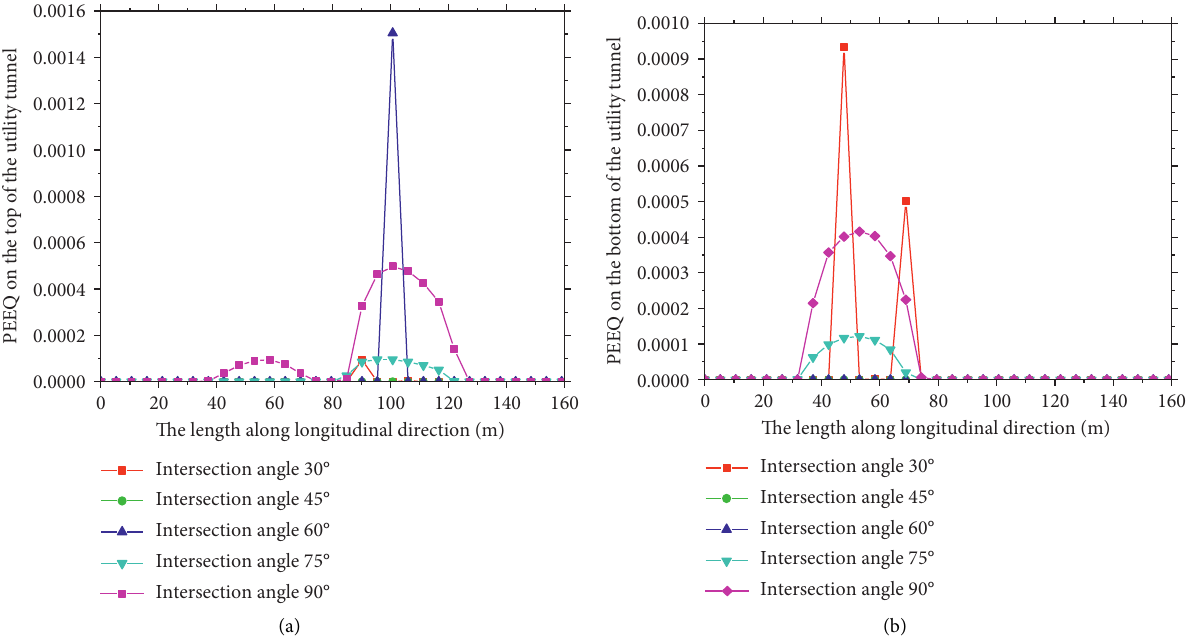
Figure 13: Equivalent plastic strain of the utility tunnel. (a) Equivalent plastic strain on the top of the utility tunnel. (b) Equivalent plastic strain on the bottom of the utility tunnel.